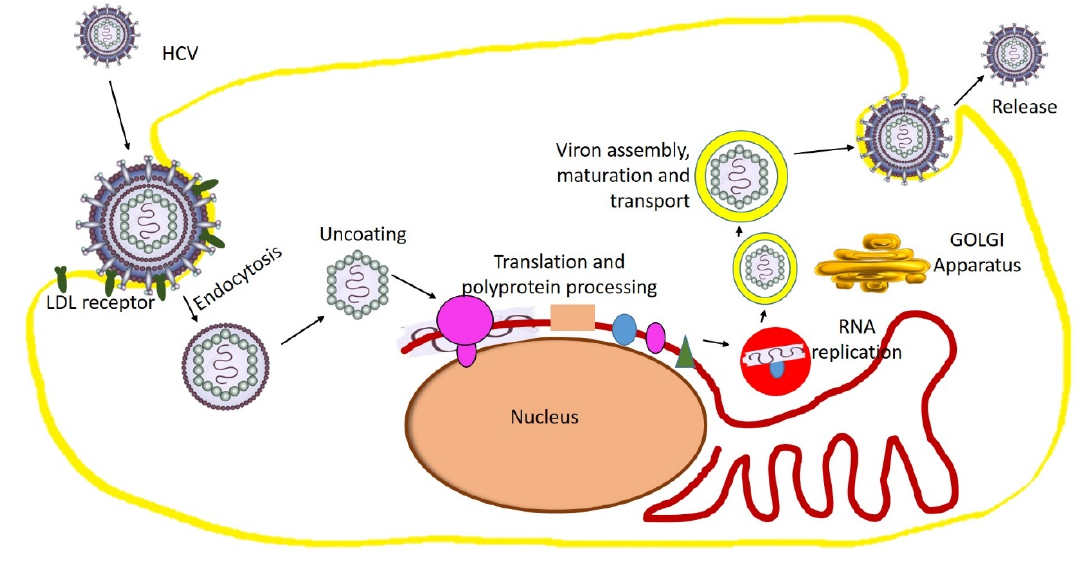
Figure 4. Hepatitis C virus structure and replication mechanism. The Ortomyxovirus structure in this figure has been modified from the source https://www.gettyimages.ae/.